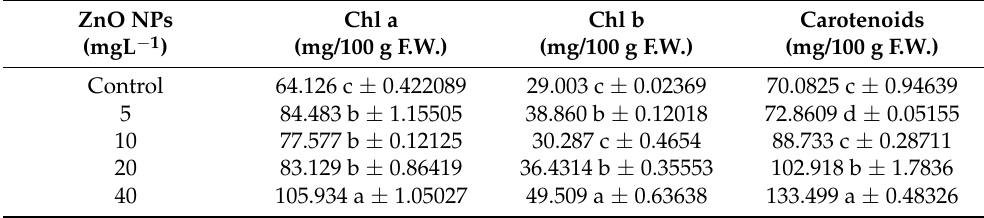
Table 3. Zinc oxide nanoparticles (ZnO NPs) impact the chlorophyll a (chl a), b (chl b), and carotenoid concentrations of C. longa leaves. Mean values followed by the same letter within a column are not significantly different at p = 0.05, as measured by Duncan’s test.